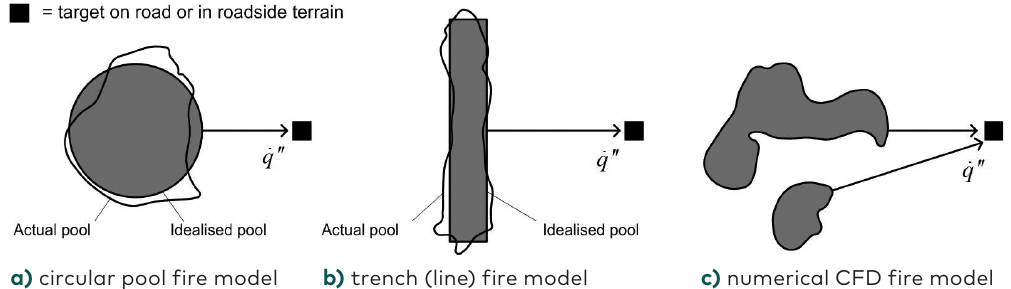
a) circular pool fire model b) trench (line) fire model c) numerical CFD fire Figure 5. Three models used to predict the fire radiation  ′′ q impinging a target on road or roadside terrain (CFD = computational fluid dynamics)